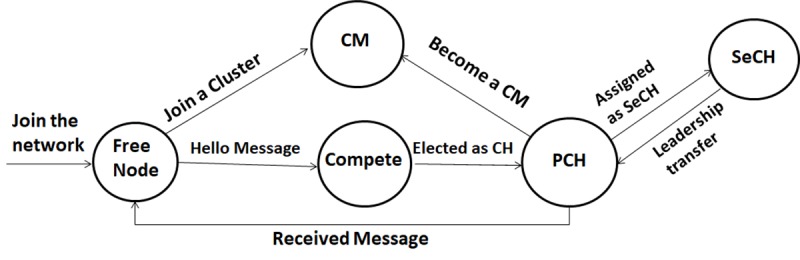
Clustering transition model.